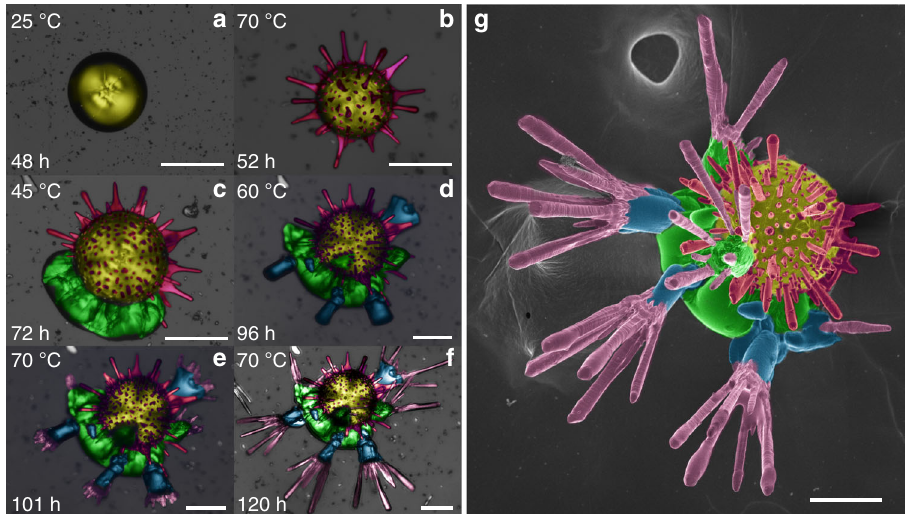
Fig. 5 Growth history of multi-textured complex architectures of MHC. The growth periods at different temperatures have been labeled with false colors in both optical micrographs ( a – f ) and FESEM image ( g ): 48 h growth at 25 °C (yellow), 4 h growth at 70 °C (magenta), 20 h growth at 45 °C (green), 24 h growth at 60 °C (blue), 24 h growth at 70 °C again (purple), successively. The multi-textured MHC experience the growth at 25 °C (0 – 48 h), 70 °C (48 – 52 h), 45 °C (52 – 72 h), 60 °C (72 – 96 h), and again 70 °C (96 – 120 h). Scale bar: 100 μ